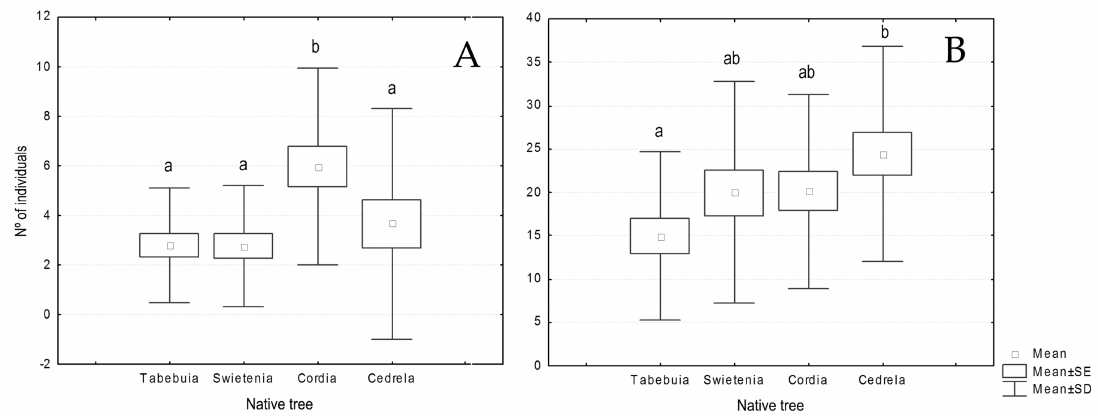
Figure 3. Mean abundances of Lepidoptera ( A ) and Coleoptera ( B ) associated to every type of timber tree. Different letters show significant differences ( p <